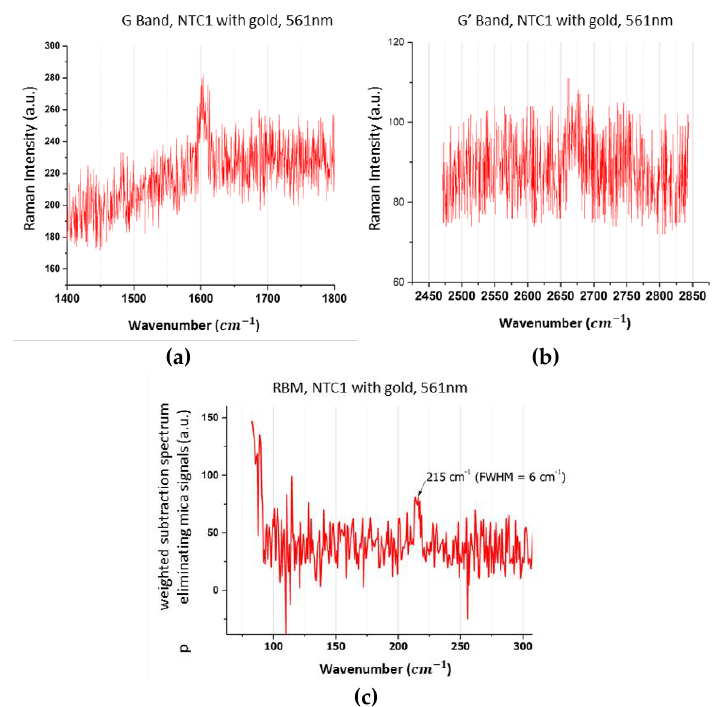
Figure 6. G ( a ) and G ’ ( b ) bands of the CNT 1 , excited at 561 nm for a low power of 3.3 μW; ( c ) RBM of the CNT 1 excited at the same power and wavelength, obtained after removing the mica substrate bands.